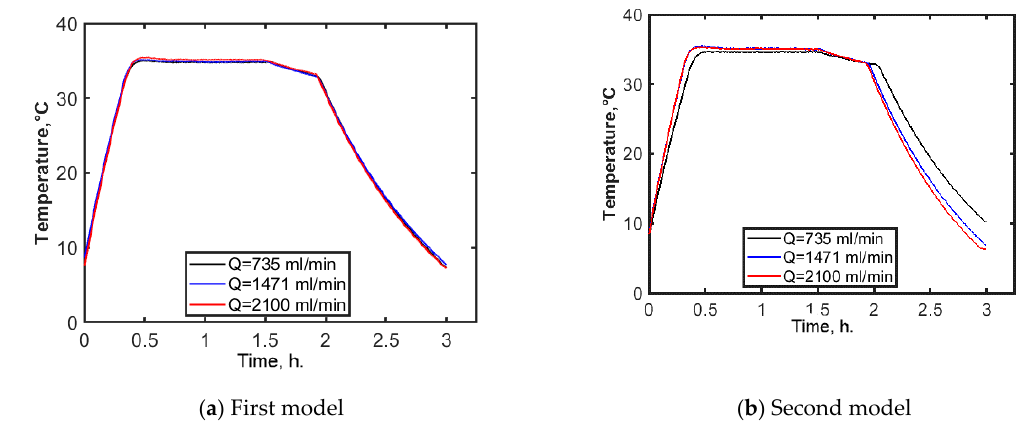
Figure 7. Inlet temperature profile at different flow rates.